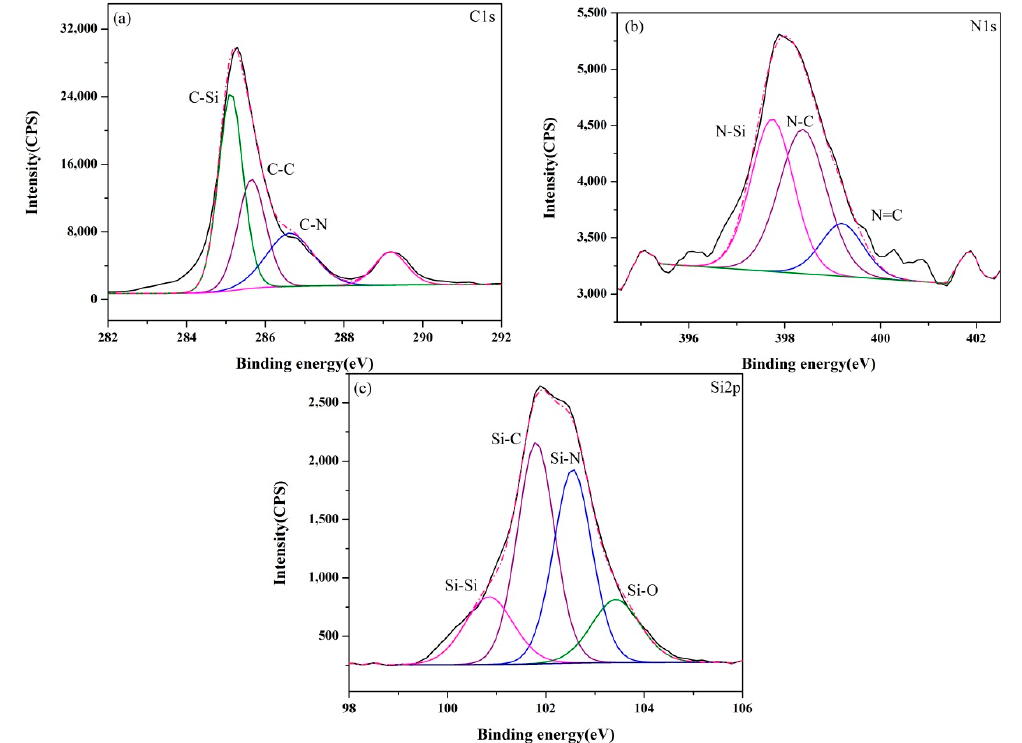
Figure 9. XPS core-level spectra of sample D synthesized at 1550 °C: ( a ) C1s, ( b ) N1s and ( c ) Si2p.